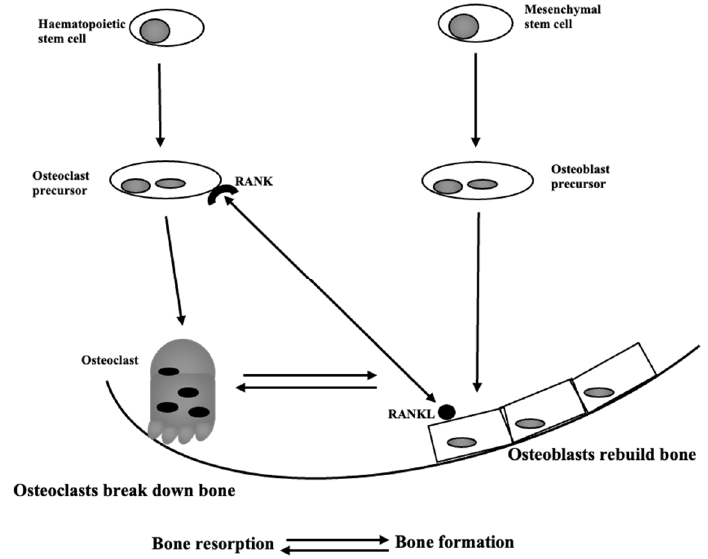
Figure 1. Maintenance of bone structure. In bony tissue, osteoclasts (derived from hematopoietic stem cells) and osteoblasts (of mesenchymal derivation) degrade and build and thus constantly remodel bone. Osteoclasts begin degrading bone, and the resorption pits are partly filled by a new bone matrix produced by osteoblasts, which is subsequently mineralized.